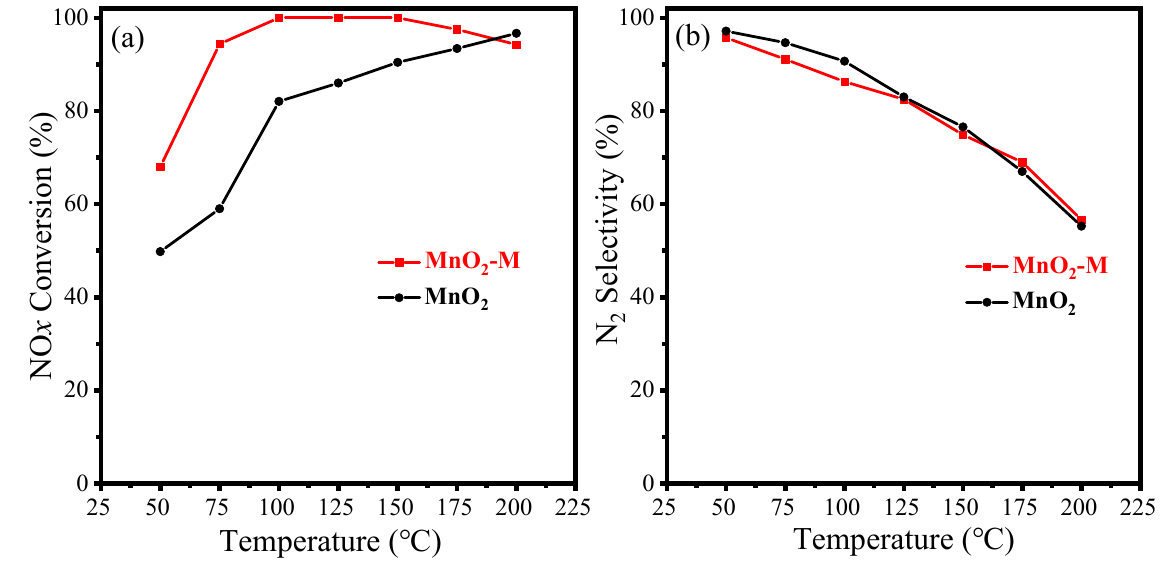
Figure 7. Catalytic performances of the catalysts NO x conversion ( a ) and N 2 selectivity ( b ) at different temperature (reaction conditions: [NO] = 500 ppm, [NH 3 ] = 500 ppm, [O 2 ] = 5%, and N 2 as balance gas, GHSV = 40,000 h −1 ).